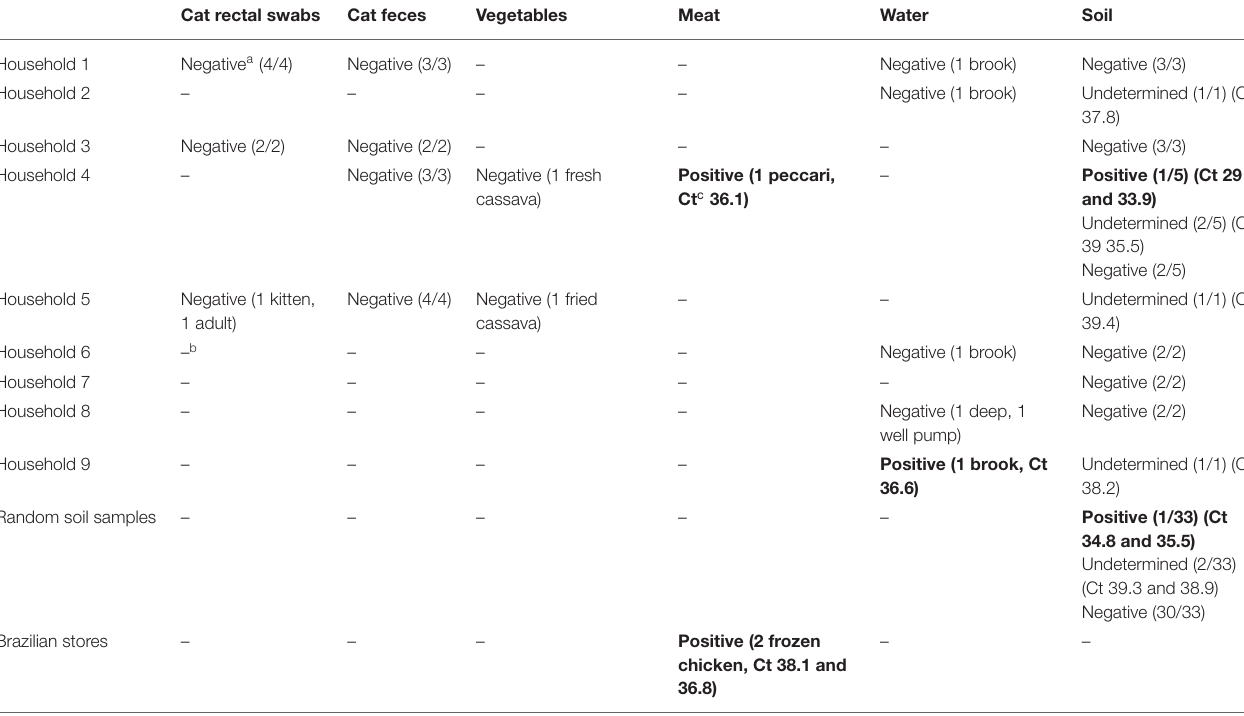
TABLE 4 | Results of Toxoplasma gondii PCR on environmental and meat samples collected during the outbreak investigation, Camopi village, French